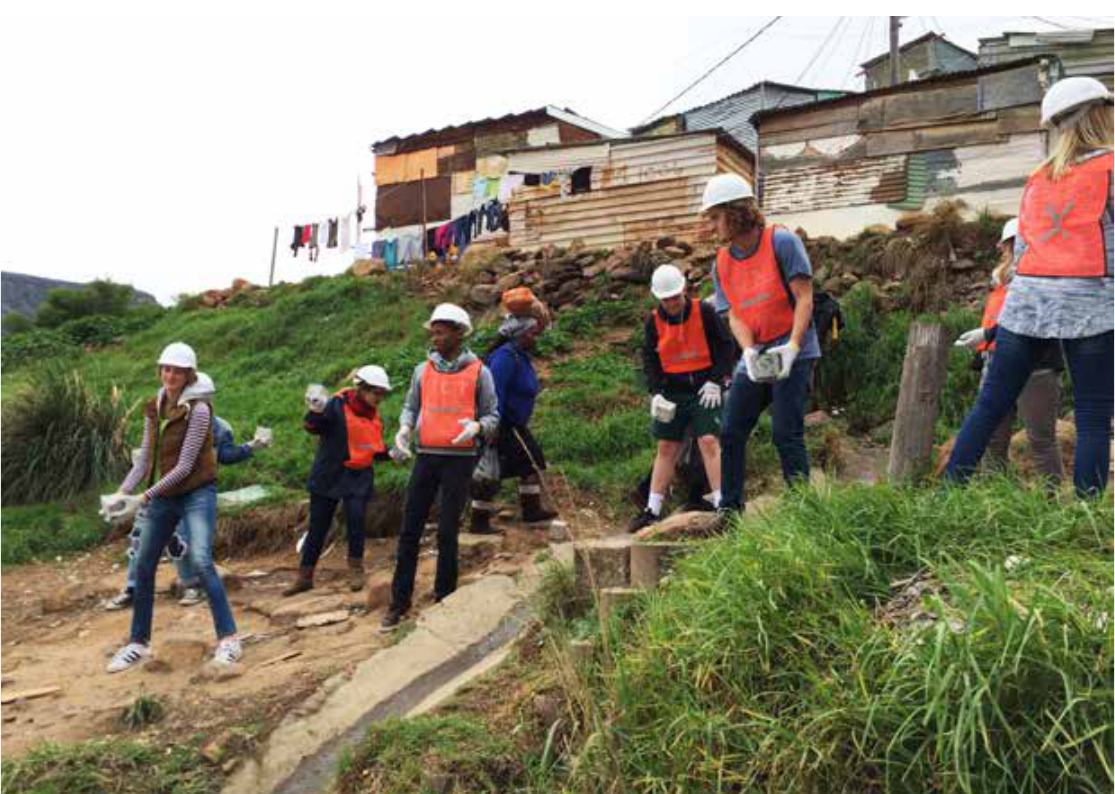
Figure 3 (page 37, top): Students assembling the formwork for the staircase that leads up to the 2012 water platform from O.R. Tambo Road in Imizamo Yethu. Source: author Figure 4 (page 37, bottom): Students passing bricks to local community members who are building a support column for the